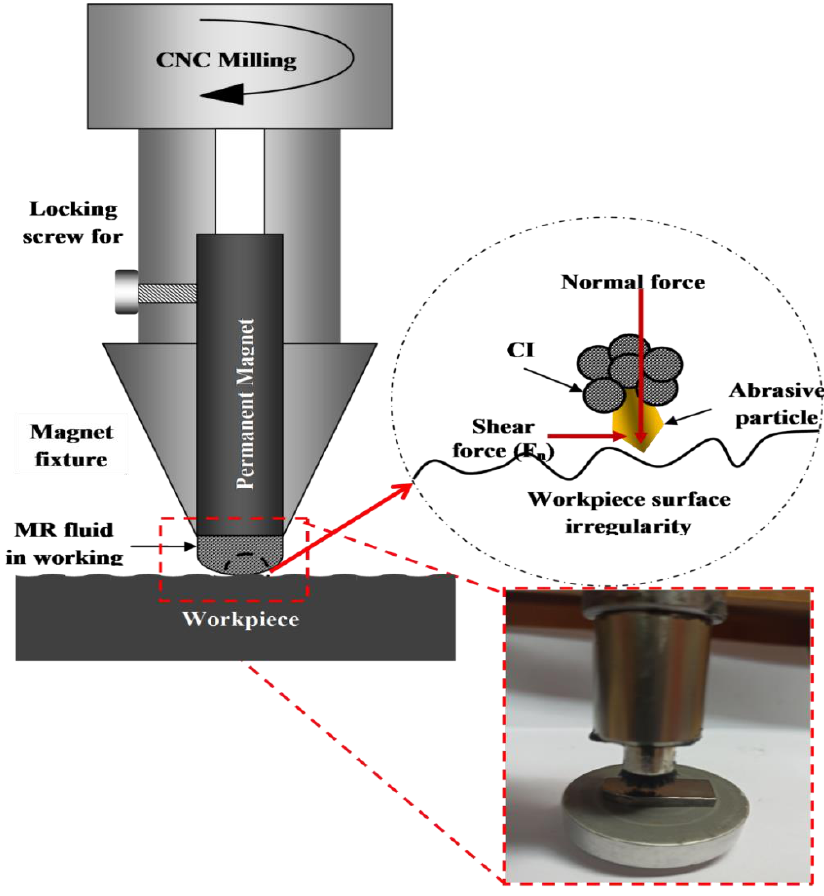
Figure 2. Pictorial representation of MRF-AF setup. Table 1. MRF-AF process parameters and their working